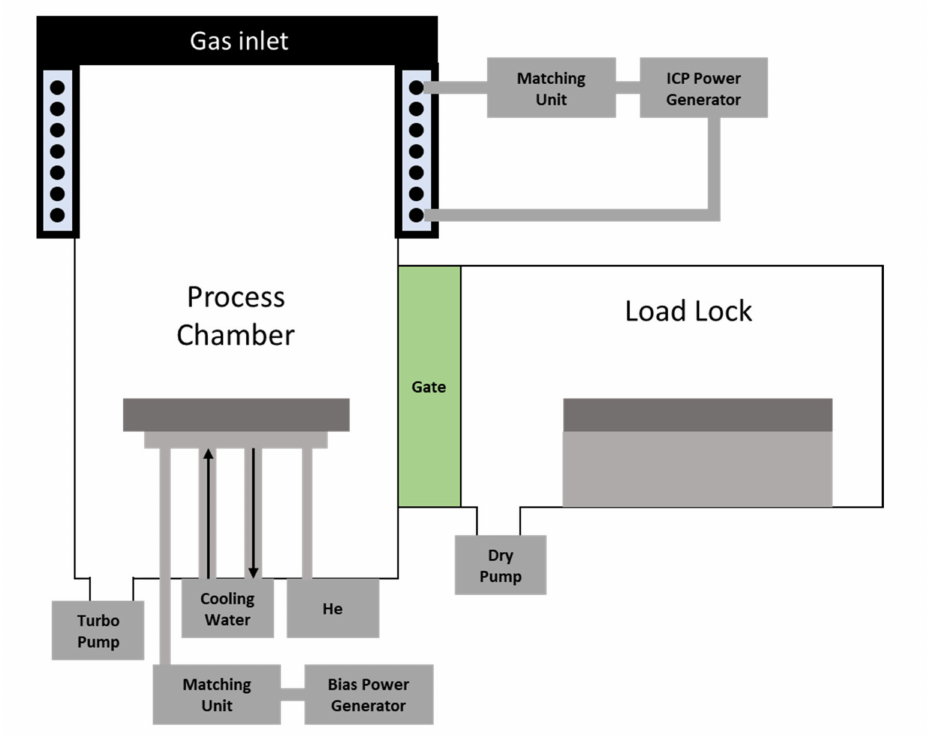
Figure 1. Schematic diagram of BMR HiEtch inductively coupled plasma (ICP)